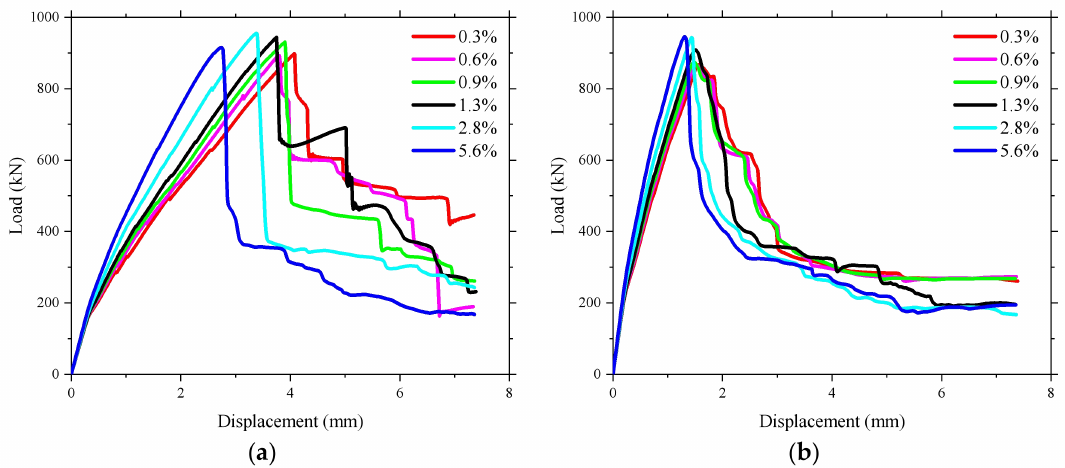
Figure 22. Influence of the reinforcement ratio on the ultimate bearing capacity. ( a ) Loading between the W-beams; ( b ) Loading between W-beams and W-beams.